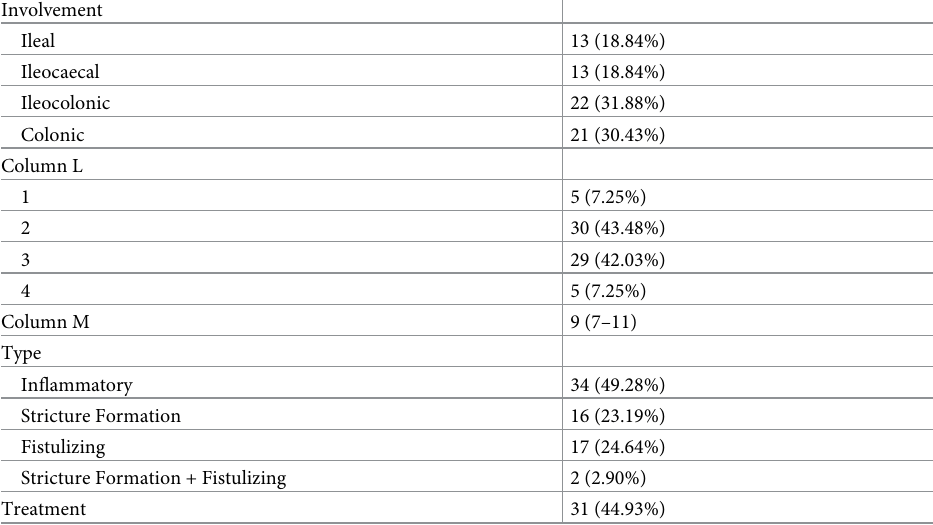
Table 3. Patients’ characteristics of Crohn’s